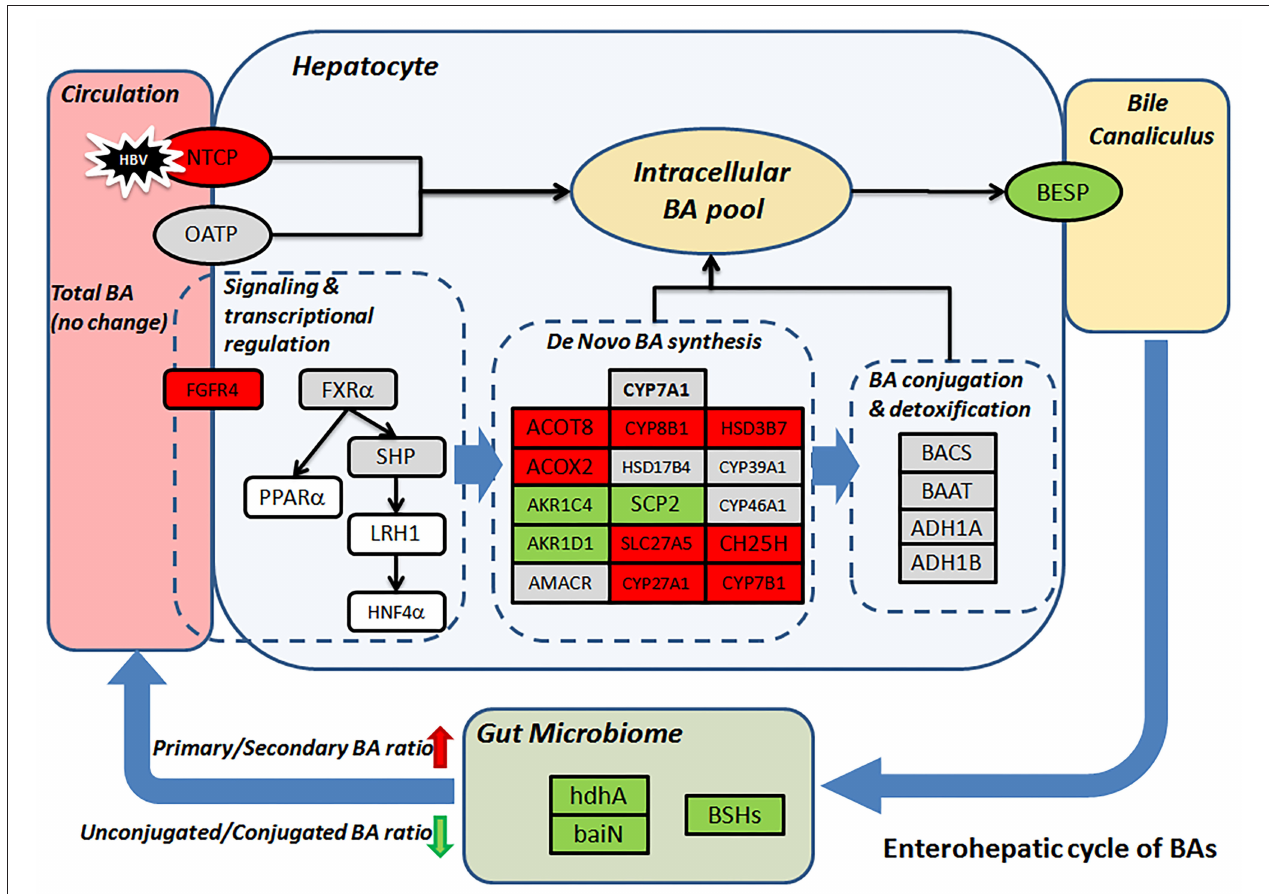
FIGURE 5 | Proposed mechanism leads to the distinct BA profile in CHB patients. Change level of BA related genes (rectangular) according to transcriptomic data was visualized by color. Red/green represent up-/down-regulation, gray, and white indicate no-changes and missing data, respectively. BSHs, hdhA and baiN levels were predicted based on microbiome 16S sequencing